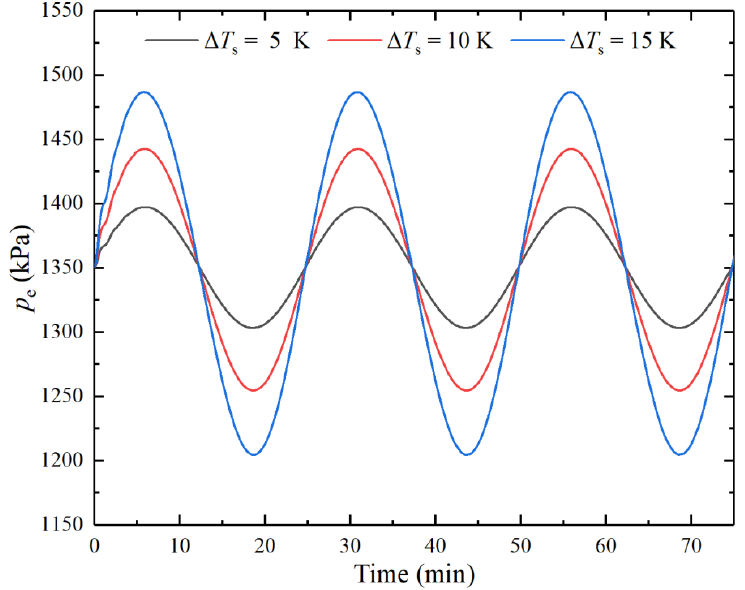
Figure 7. Evaporating pressure under different amplitudes.